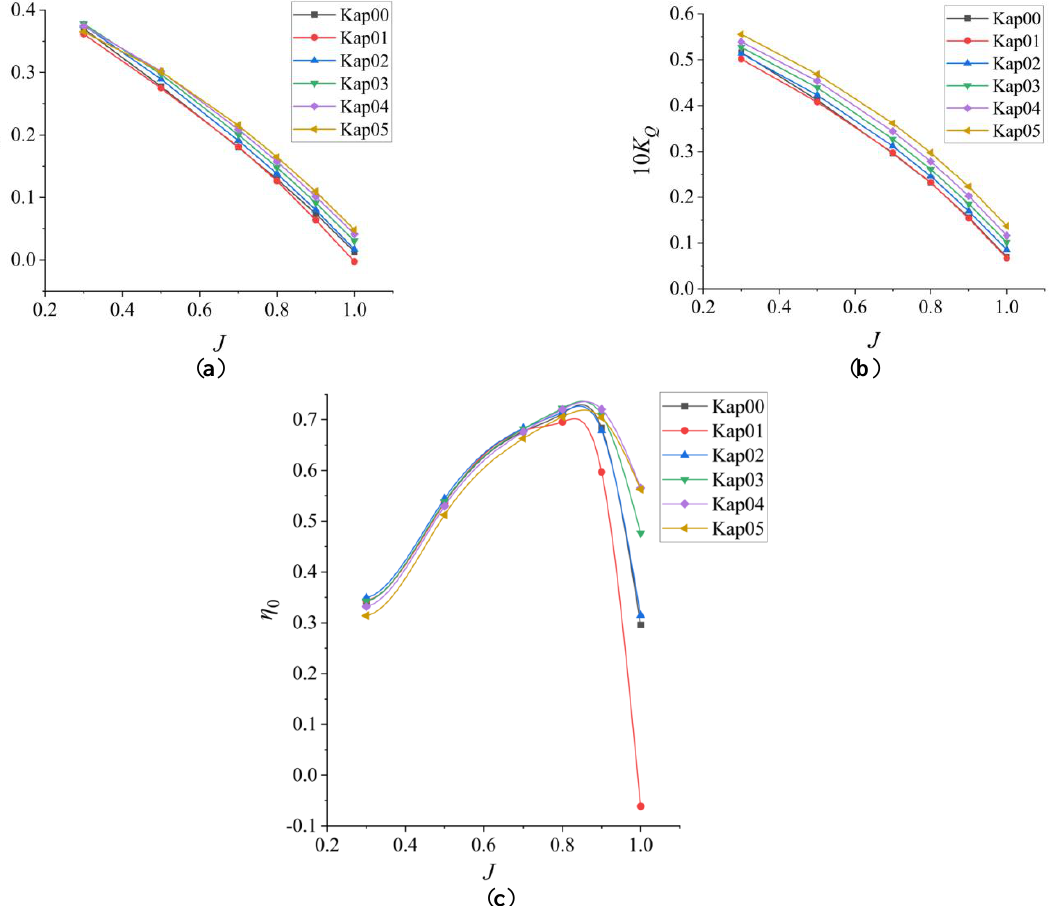
Figure 10. Comparison of open-water performance of Kappel propellers with different tip rakes (12 rps, σ = 2.0). ( a ) K T , ( b ) 10 K Q , ( c ) η o